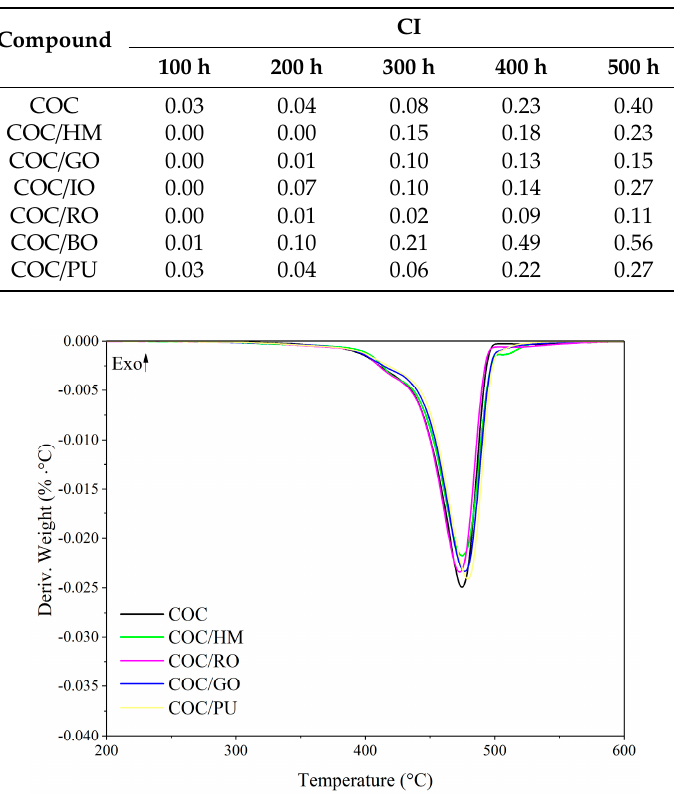
Figure A1. Derivate thermogravimetric (DTG) curves obtained for COC composites filled with di ff erent earth pigments measured in an inert atmosphere.